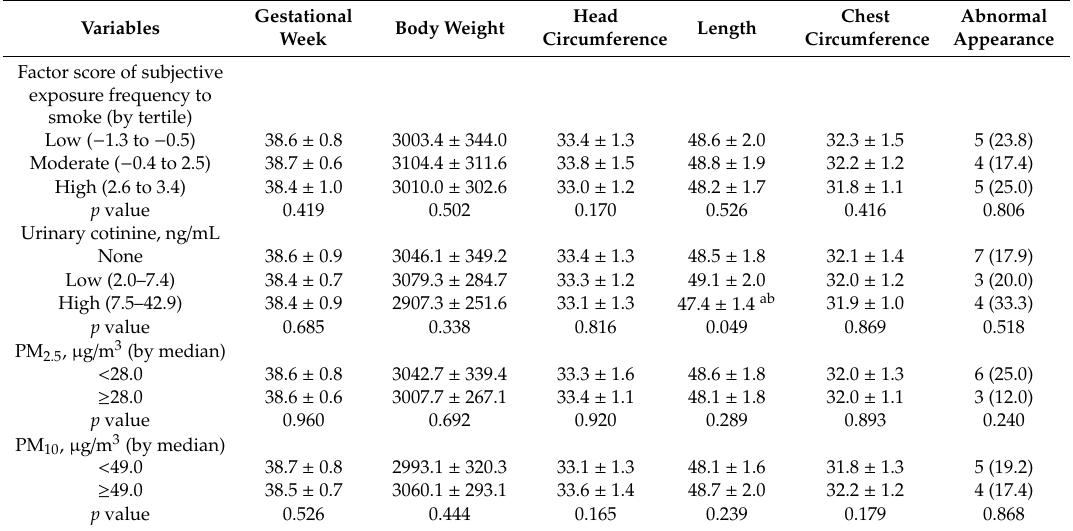
Chest Abnormal Gestational Head Body Weight Length Week Circumference Circumference Appearance